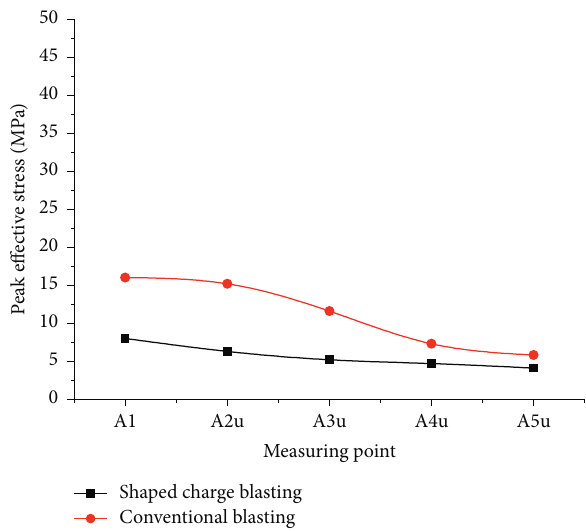
Figure 12: Peak effective stress of measuring point at the vertical direction of the blast hole center